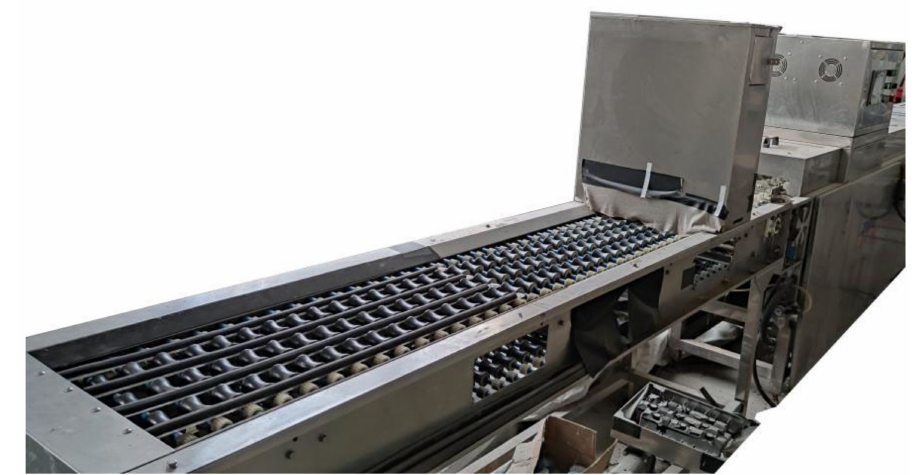
Figure 3. The online image acquisition device for preserved